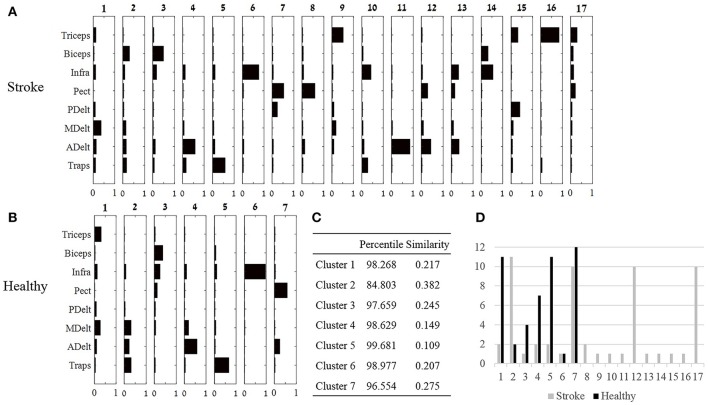
Cluster analysis. (A,B): Seventeen and seven clusters optimally represent the synergies of the study and control group, respectively. Large number of clusters post-stroke suggests that individuals recruit different synergies, whereas decreased number of clusters in the control group, suggest that different individuals uses similar synergies. (C) The optimal similarities of seven clusters between groups and percentile of similarity among random synergies were computed. Six out of seven clusters were similar between groups. (D) The number synergies (y axis) that were classified to each cluster in both groups.